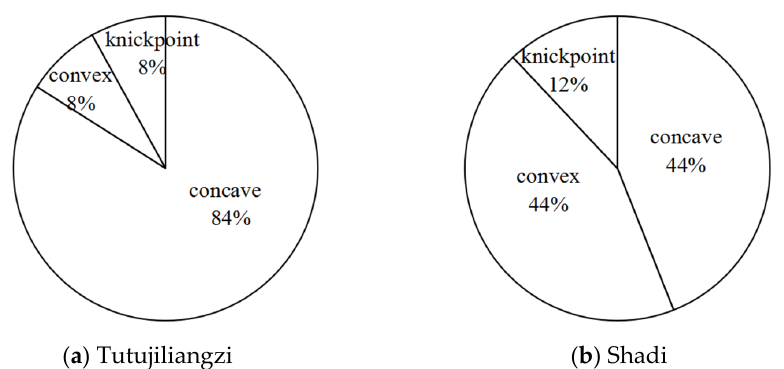
Figure 4. Percentage of longitudinal profile morphology.